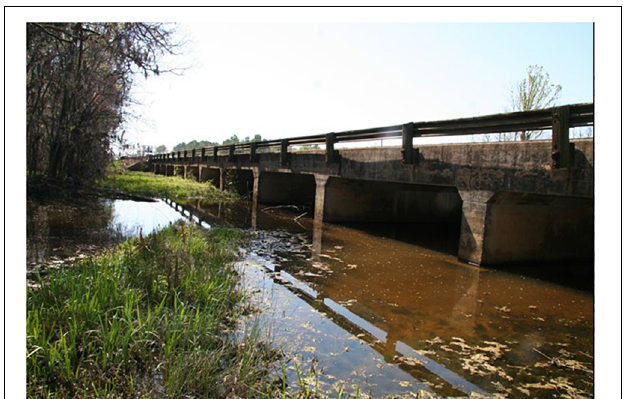
FIGURE 1 | Side view of the bridge.